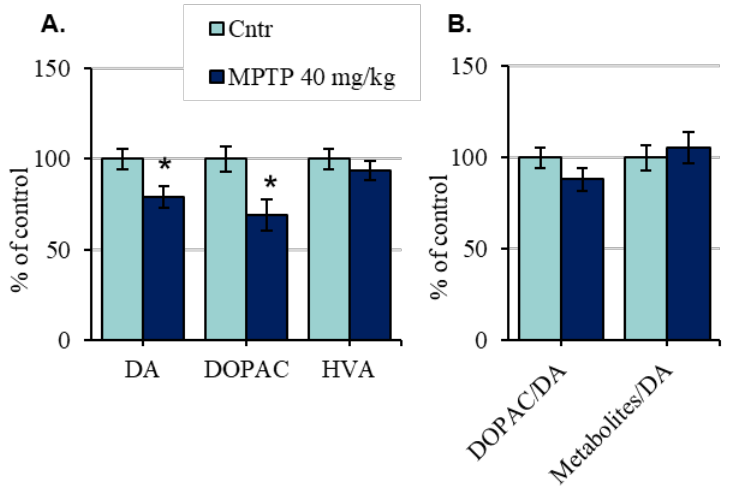
Figure 4. The content of dopamine (DA), 3,4–dihydroxyphenylacetic acid (DOPAC), and homovanillic acid (HVA) ( A ), as well as DA turnover, calculated as DOPAC/DA or Metabolites/DA ((DOPAC + HVA)/DA) ( B ), presented as % of the control, in the substantia nigra of mice 24 h after a single injection of 1-methyl-4-phenyl-1,2,3,6-tetrahydropyridine (MPTP) at a dose of 40 mg/kg. * p < 0.05, significant differences compared with the control, taken as 100% (the Student’s t -test). n = 8. Data are presented as mean ± SEM. Cntr—the control group received 0.9% NaCl.